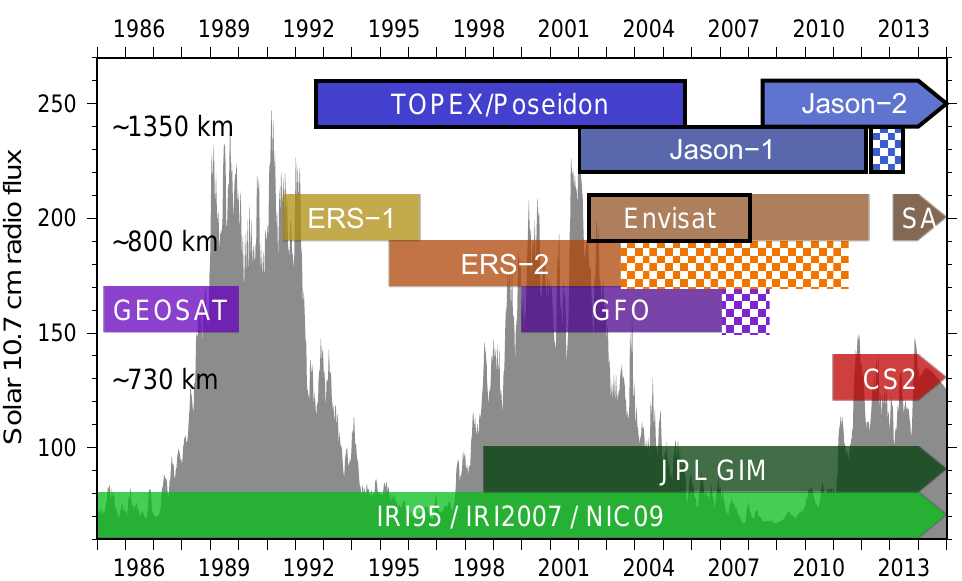
Figure 20. Variation of solar 10.7 cm radio flux during the last three solar cycles. The duration of the altimeter missions is shown by rectangles. Outlined rectangles of TOPEX, Jason-1, Jason-2 and Envisat indicate the availability of dual-frequency measurements. The checkered patterns indicate limited data coverage or extended missions. CS2, CryoSat-2; SA, SARAL/AltiKa. Global TEC models are shown at the